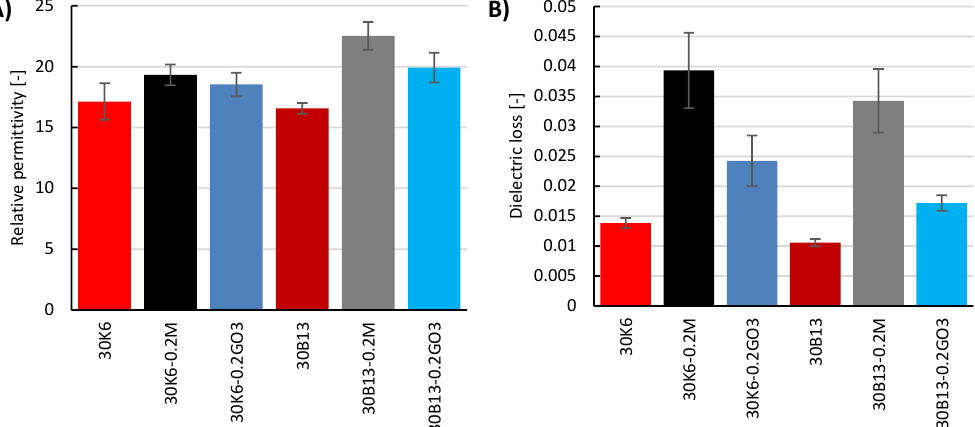
Figure 4. Room temperature dielectric properties of piezoelectric composites, with applied silver ink electrodes, before poling at 1 kHz: ( A ) relative permittivities; ( B ) dielectric